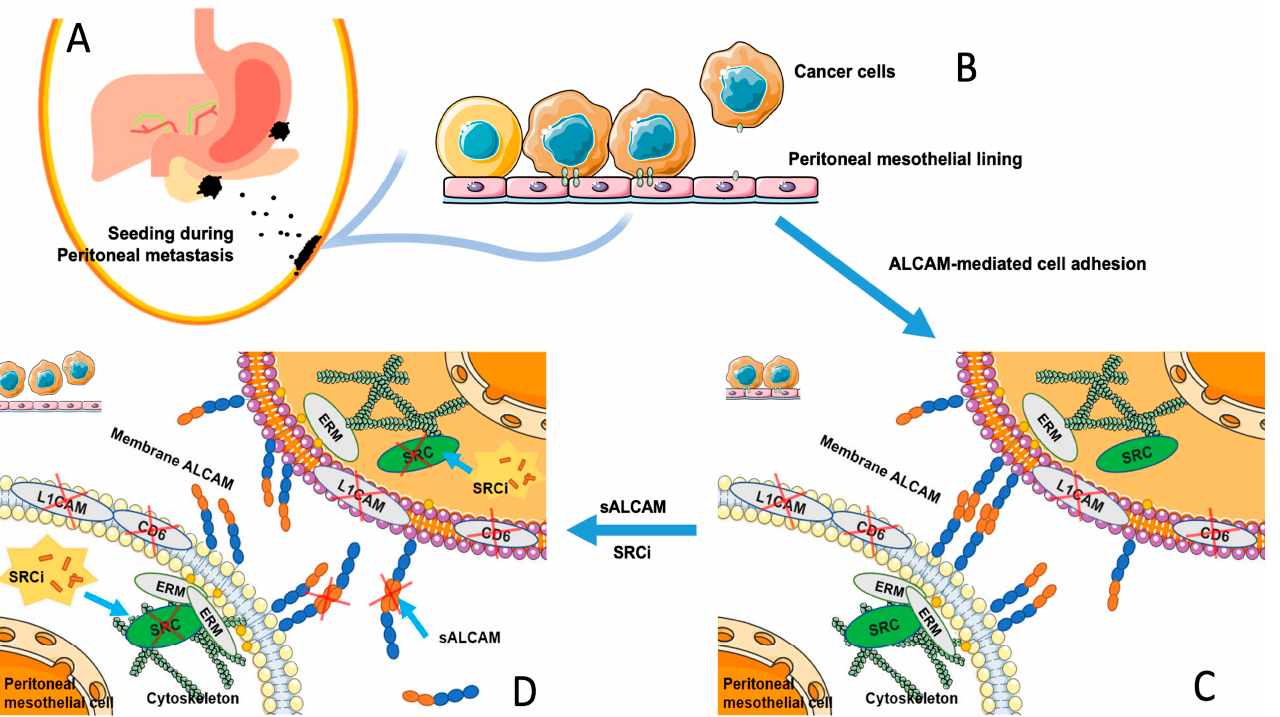
Figure 12. The proposed mechanism of ALCAM mediated tumour-endothelial interactions. Follow- ing shedding of cancer cells from the primary site, stomach or pancreas ( A ), the metastatic cancer cells (seeds) in the abdominal cavity come to contact the peritoneal mesothelial cells (‘soil’) ( B ), all expressed high levels of ALCAM but neither expressed CD6 or L1CAM ( C ), which initiates the ALACAM-ALCAM homotypic interaction. Supported by the machinery including the subcoat pro- tein ERM and signalling kinase SRC, ALCAM mediates the tumour-mesothelial interaction. Soluble ALCAM as an extracellular antagonist or small compound inhibitory molecule to SRC kinase as intracellular inhibitor, can disrupt this ALCAM-ALCAM mediated tumour-endothelial interaction ( D ) and offer a potential therapeutic